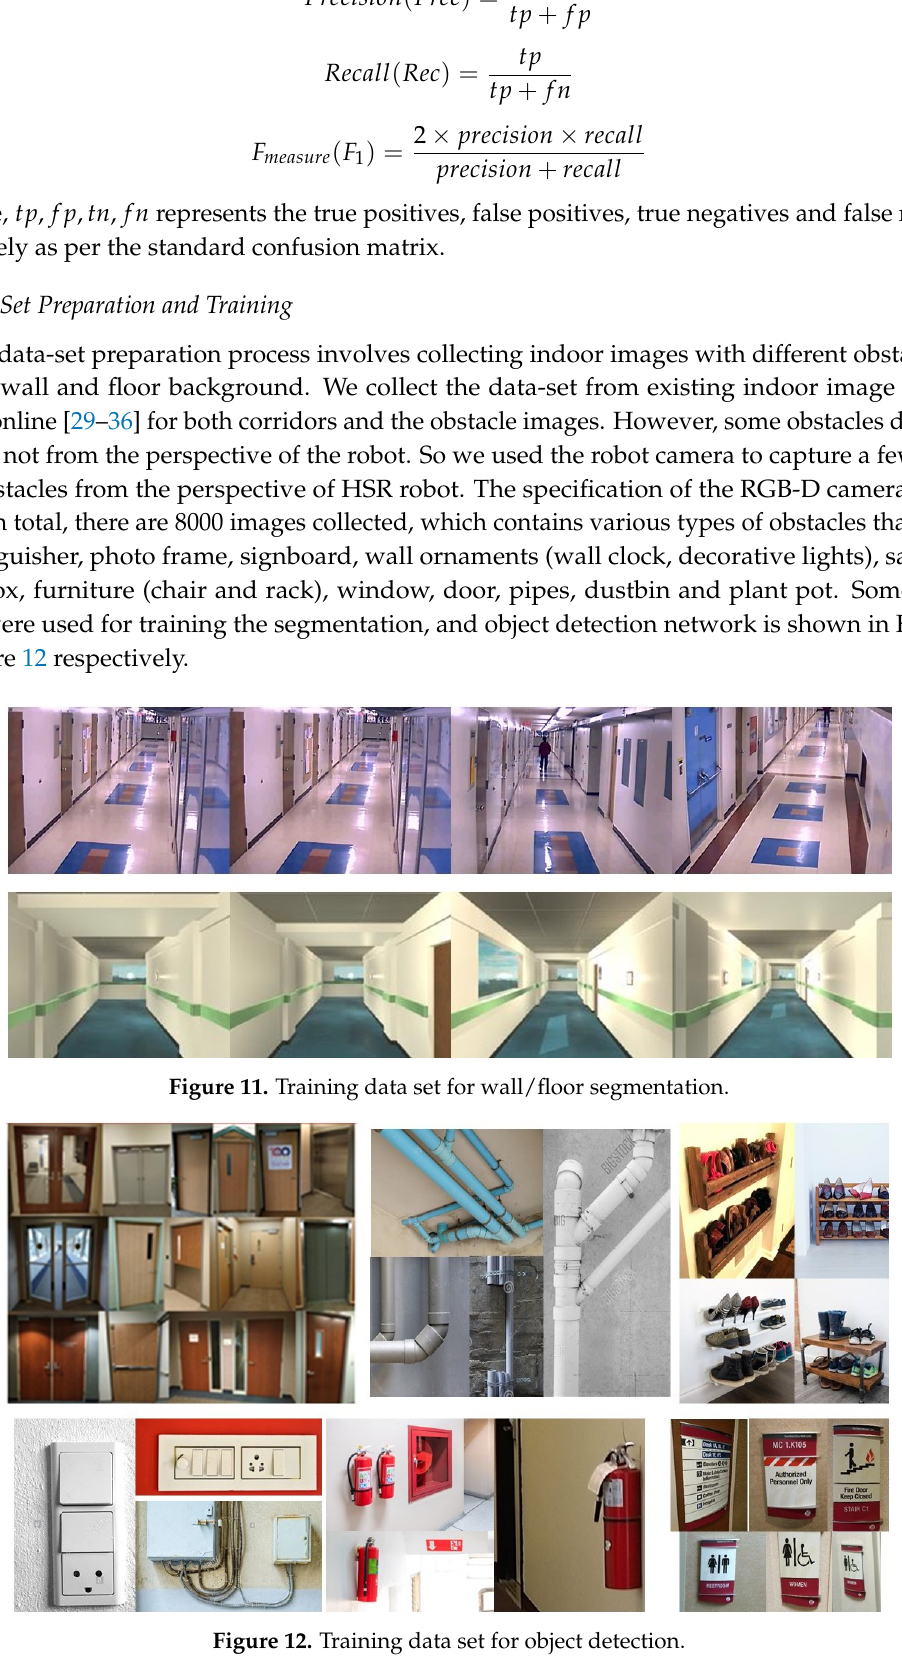
Figure 12. Training data set for object